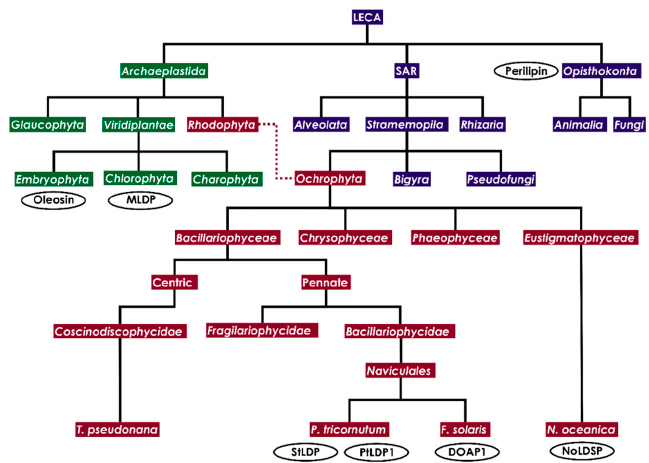
Figure 1. Cladogram illustrating major eukaryotic lineages in relation to diatoms. Thick black lines indicate nuclear inheritance; dotted line indicates plastid inheritance (intermediate stages not shown). Encircled in black font are representative lipid droplet proteins unique to model lineages. LECA = Last Eukaryotic Common Ancestor, MLDP = Major Lipid Droplet Protein, StLDP = Stramenopile Lipid Droplet Protein, PtLDP1 = P. tricornutum Lipid Droplet Protein 1, DOAP1 = Diatom Oleosome Associated Protein 1, NoLDSP = N. oceanica Lipid Droplet Surface Protein.